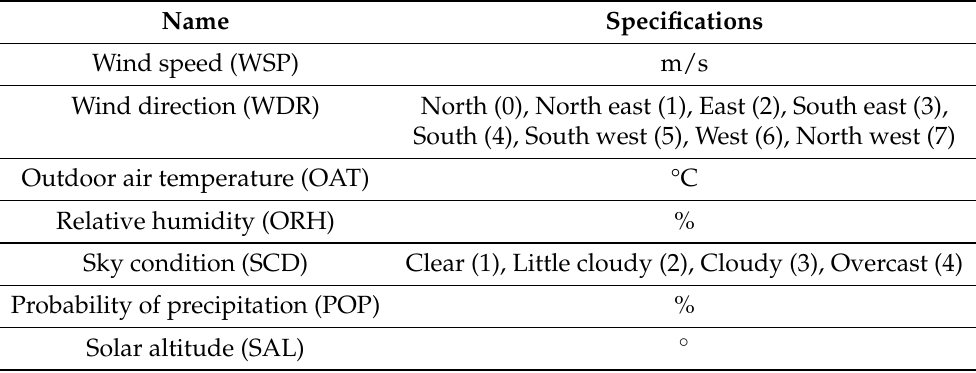
Table 1. Characteristics of online weather forecasting